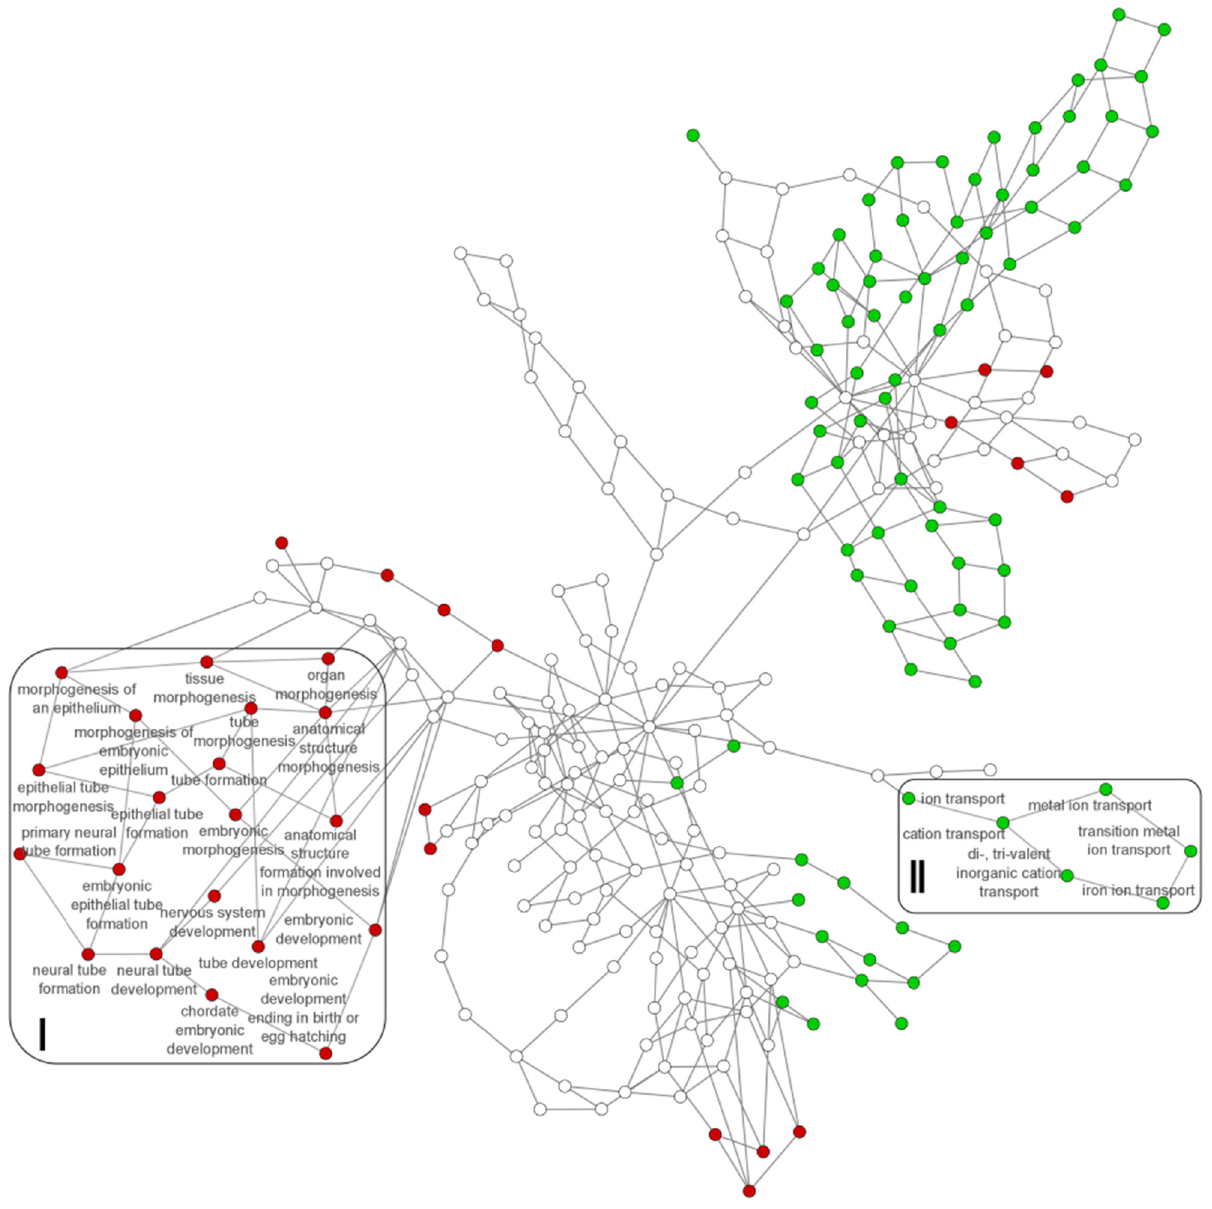
Figure 6: The hierarchical DyNet networks of GO biological process. Green circles – GO categories identi fi ed only in amylase - depleted saliva samples prepared by in - solution protocol B, red circles – GO categories identi fi ed only in amylase - depleted saliva samples prepared according to FASP protocol D2, and white circles – GO categories identi fi ed in both